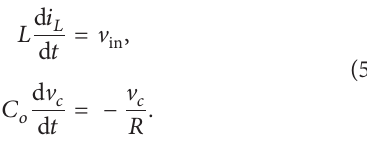
Figure 3: The key waveform of the converter with positive input